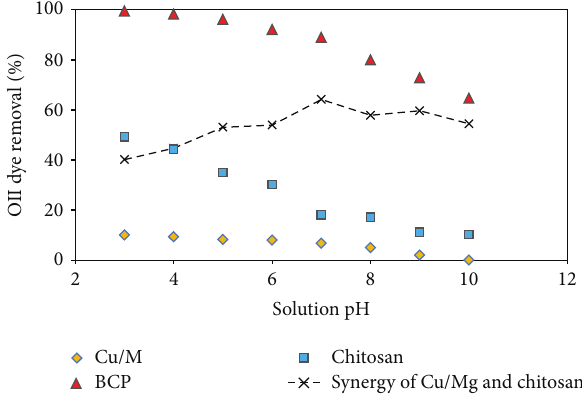
Figure 2: The synergy effect of Cu/Mg and chitosan during OII removal by BCP (OII concentration 200 mg/L, reaction time 10 min, and BCP and chitosan dose